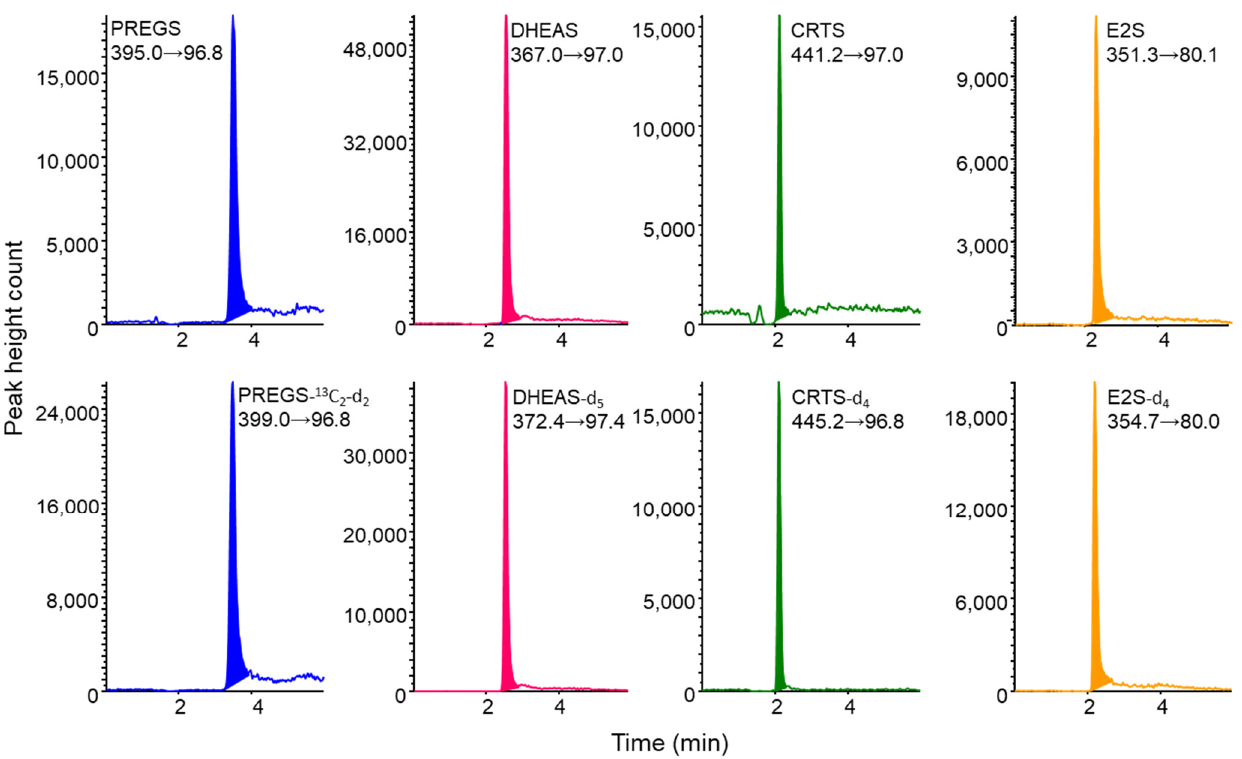
Figure 3. Multiple reaction monitoring (MRM) chromatograms obtained from standard solution containing 0.2 ng mL –1 each of PREGS, DHEAS, and CRTS and 1 ng mL –1 of E2S, and their stable isotope-labeled compounds. IT-SPME LC–MS/MS conditions are described in Section 3.